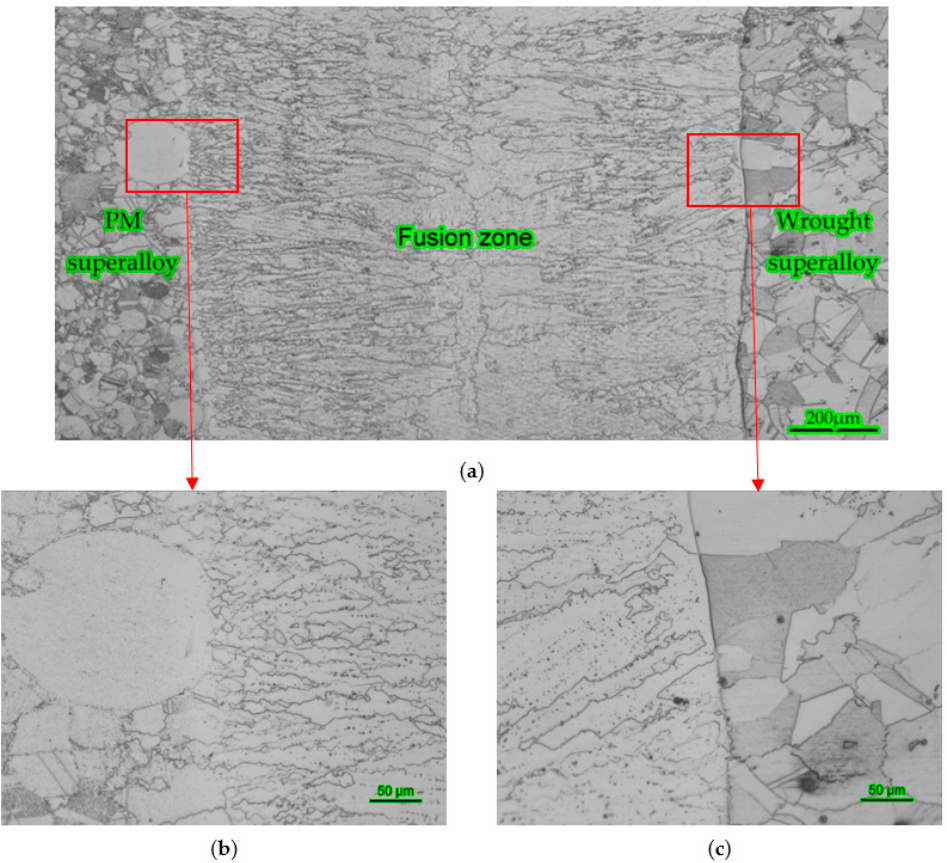
Figure 2. Typical microstructure of the PM / Wrought dual superalloy. ( a ) Optical micrograph showing previous particle boundaries (PPBs) network in base metal PM superalloy, dendrite microstructure in fusion zone, and equiaxed microstructure in base metal wrought superalloy; ( b ) Optical micrograph showing no boundary between PM superalloy and fusion zone at higher magnification; ( c ) Optical micrograph showing obvious boundary between fusion zone and wrought superalloy at higher magnification.